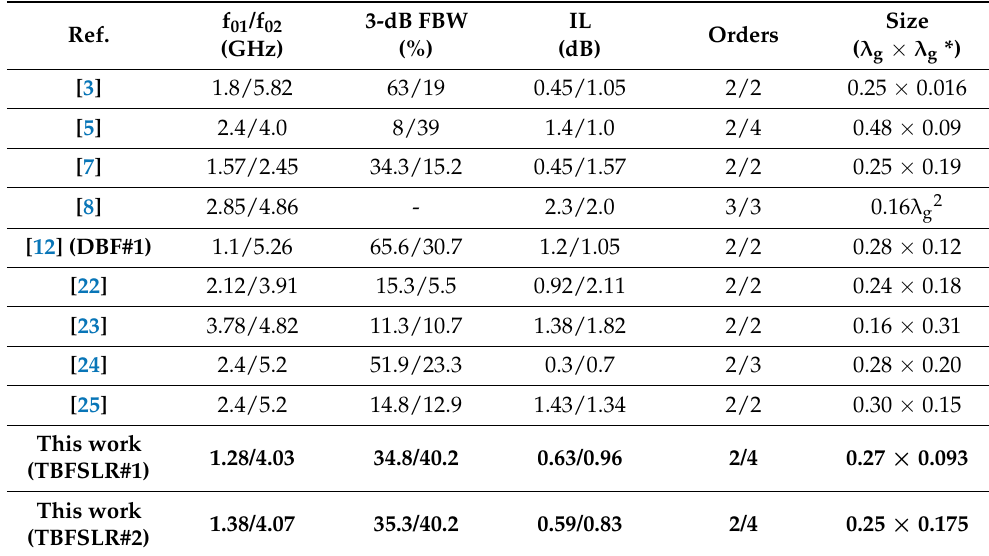
Figure 18. Comparison between the simulated and measured frequency responses of two-band BPFs with 2nd/4th order ( a ) TBFSLR#1 ( b ) TBFSLR#2. Table 2. Comparison of the proposed two-band bandpass filters with similar filters in the literature.